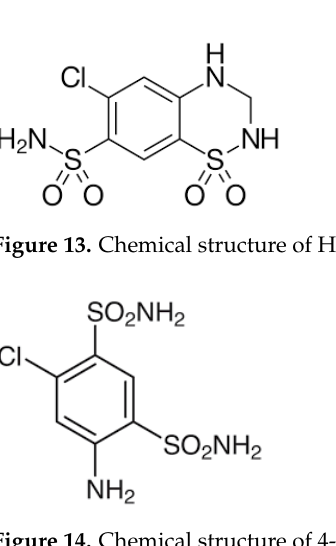
Figure 14. Chemical structure of 4-amino-6-chloro-1,3-benzenedisulfonamide